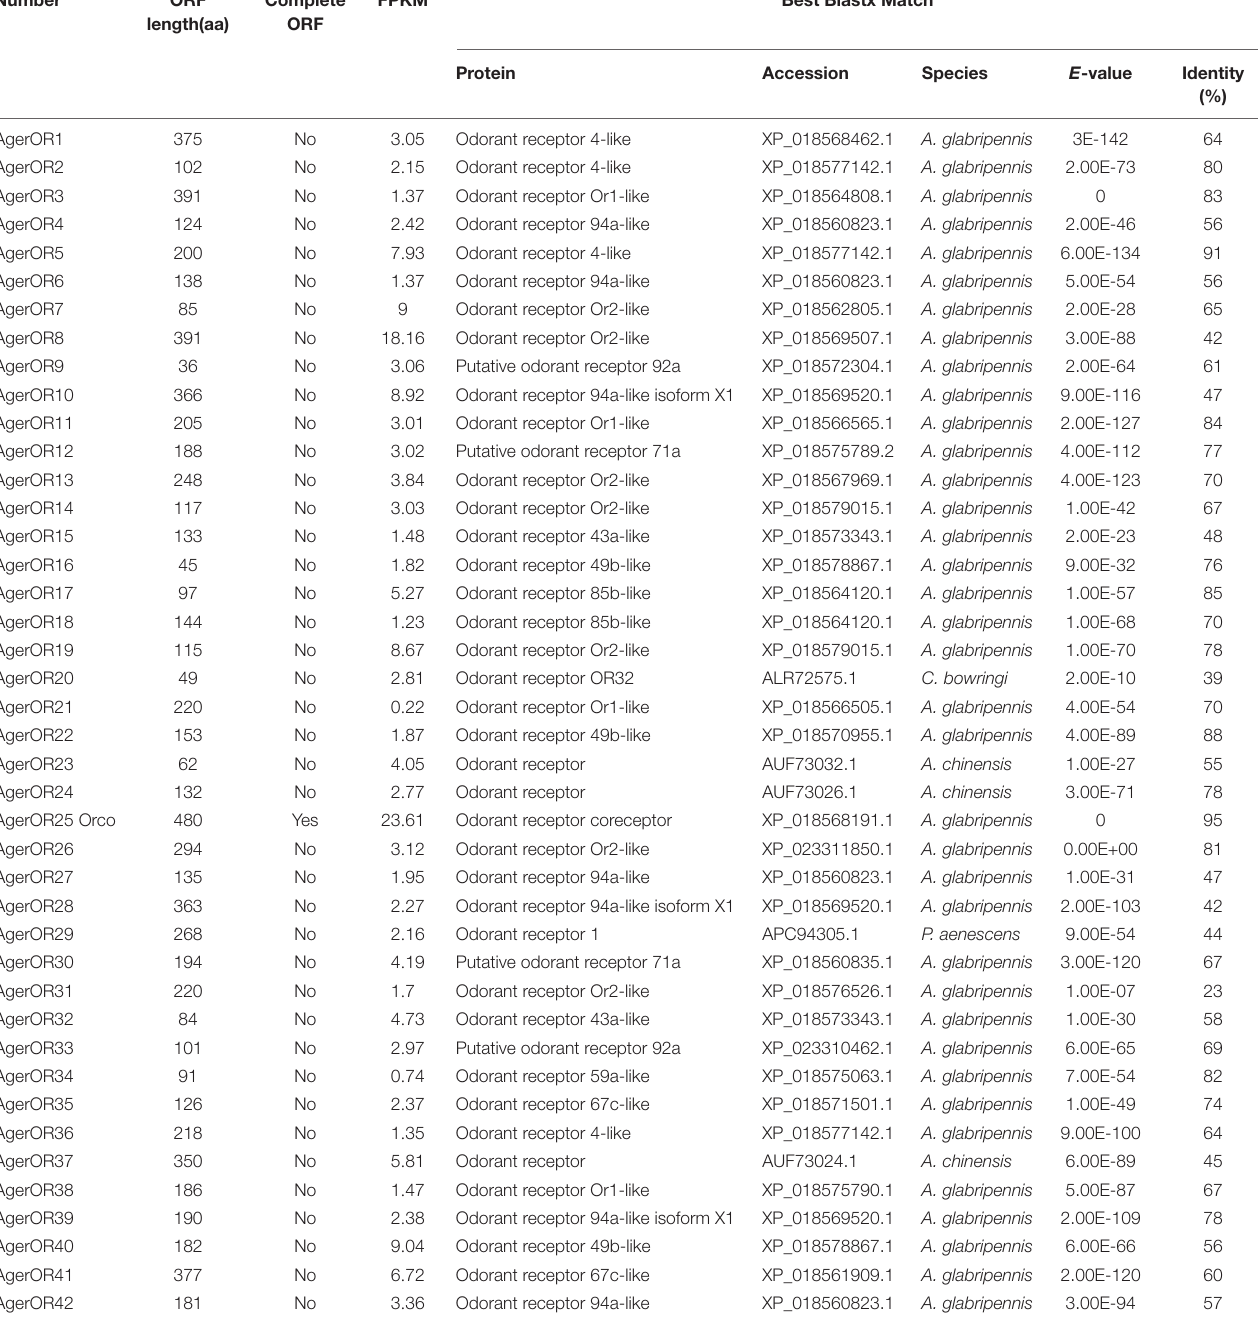
TABLE 2 | Blastx match of A. germari OR